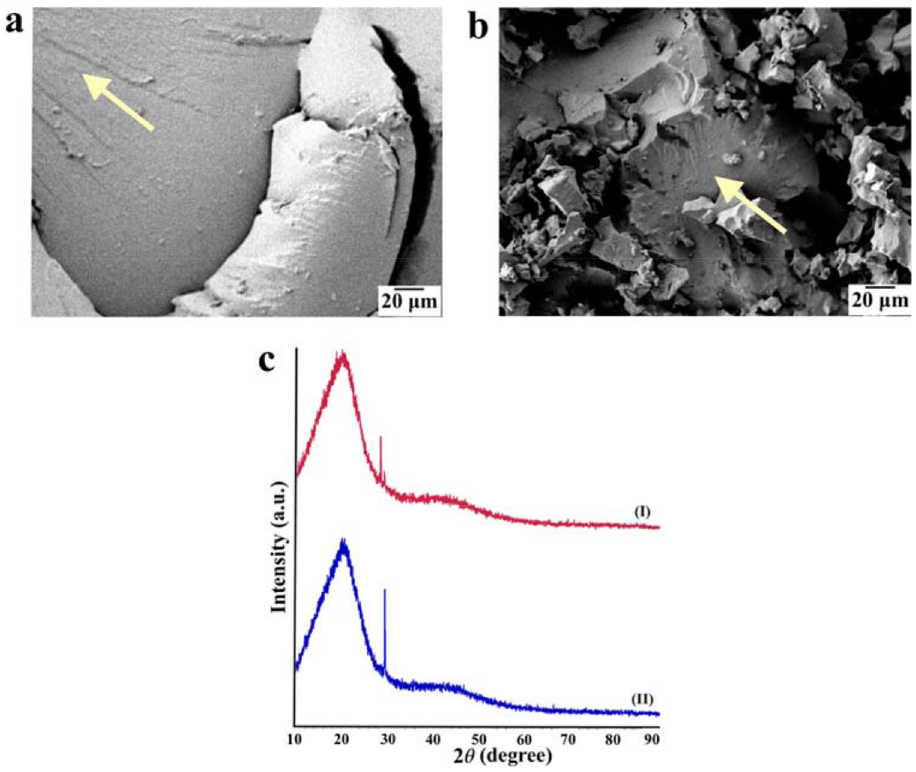
Figure 7. (a) Fractographies showing interspherulitic damage (the spherulites can be seen highlighted by arrows) for the neat PU and (b) nanocomposite; (c) X-ray diffractograms of the neat PU (I) and nanocomposite